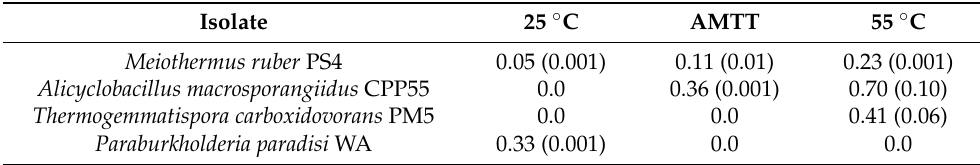
Table 1. Growth rate constants (k, h − 1 ) for isolates incubated at 25 ◦ C, under the AMTT regime or at 55 ◦ C. Values are means of triplicate determinations ± 1 standard error.